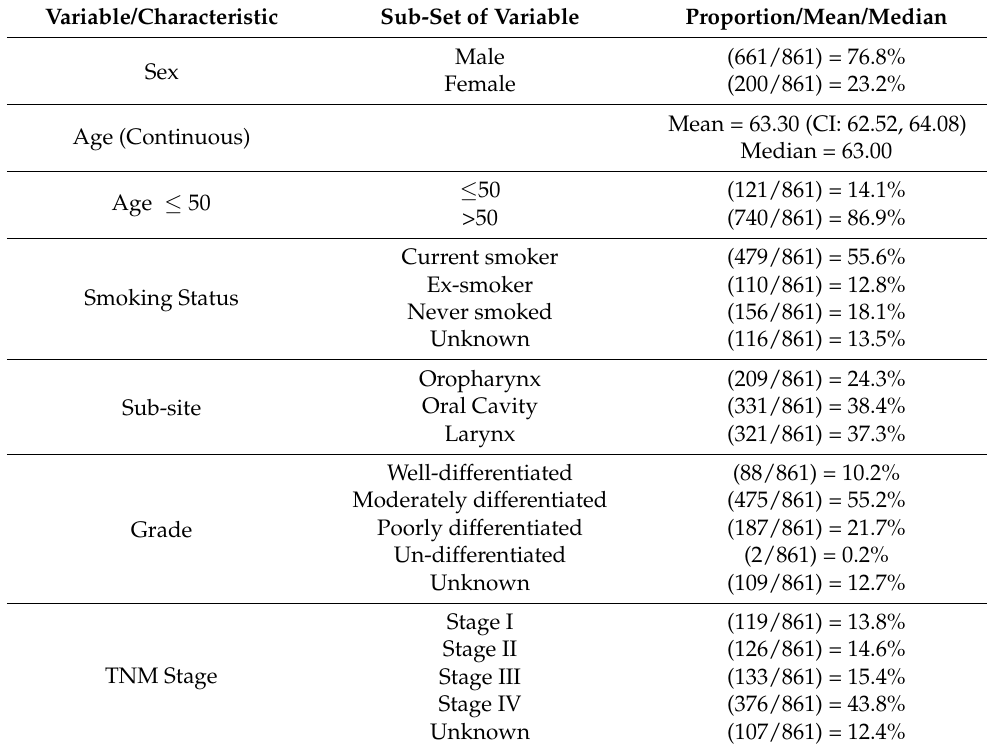
Table 4. Summary of the study